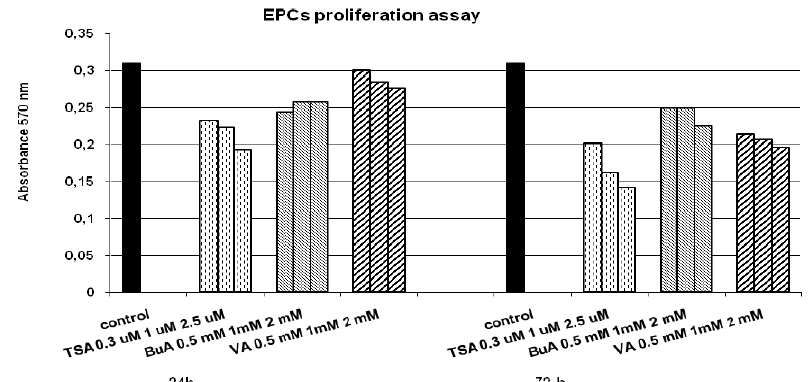
Figure 2. EPCs proliferation in the presence of different concentrations of HDAC inhibitors and at different time intervals.